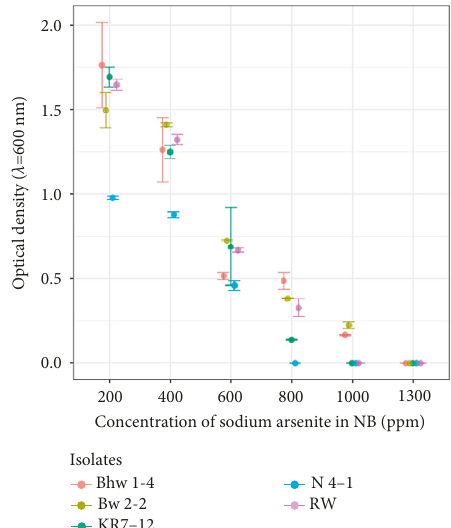
Figure 1: Growth of isolates in the arsenite-containing medium.